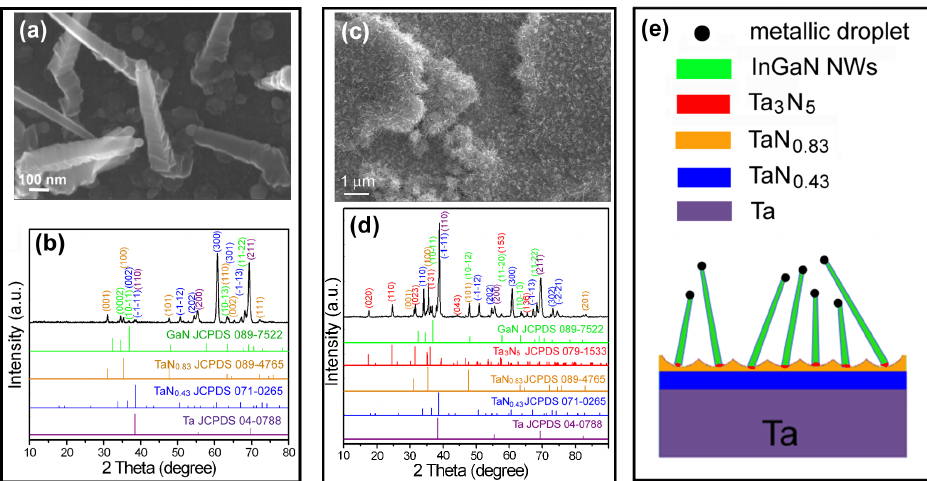
Figure 5. ( a ) The enlarged top-view SEM image and ( b ) XRD spectrum of the nitrided sample from a thin dimpled Ta surface; ( c ) the top-view SEM image and ( d ) XRD spectrum of the nitrided Ta sample with a thick tubular oxide film after CVD growth using catalysts of Ni1Au1. ( e )